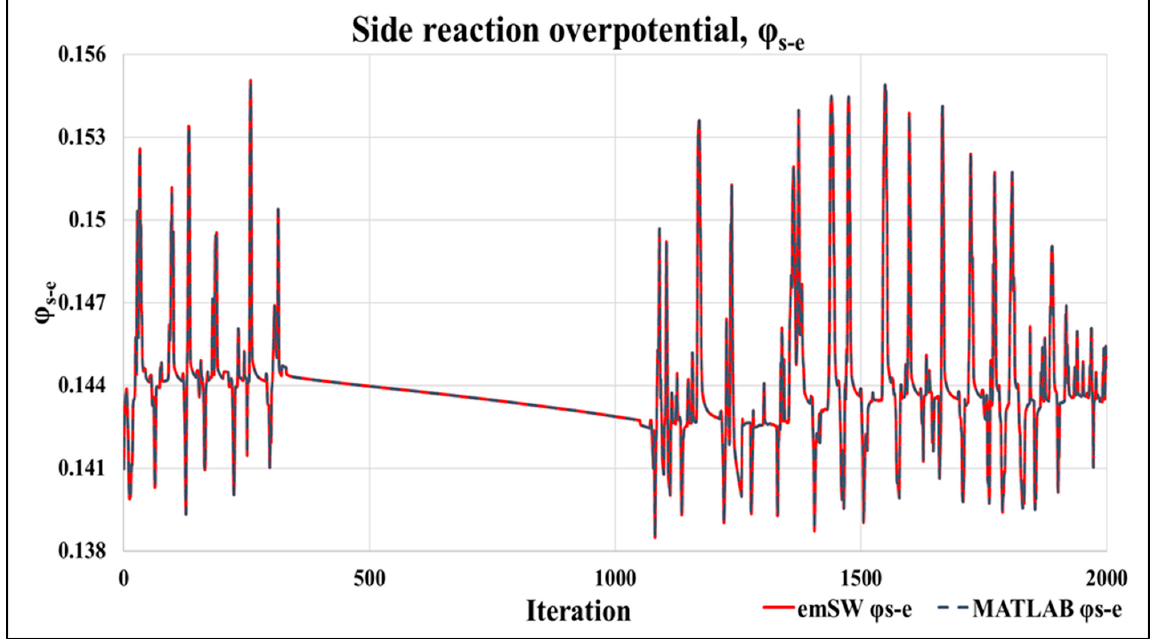
Figure 6. Side ‐ reaction overpotential ( (cid:2030) (cid:3046)(cid:2879)(cid:3032) ): proposed embedded software vs. baseline